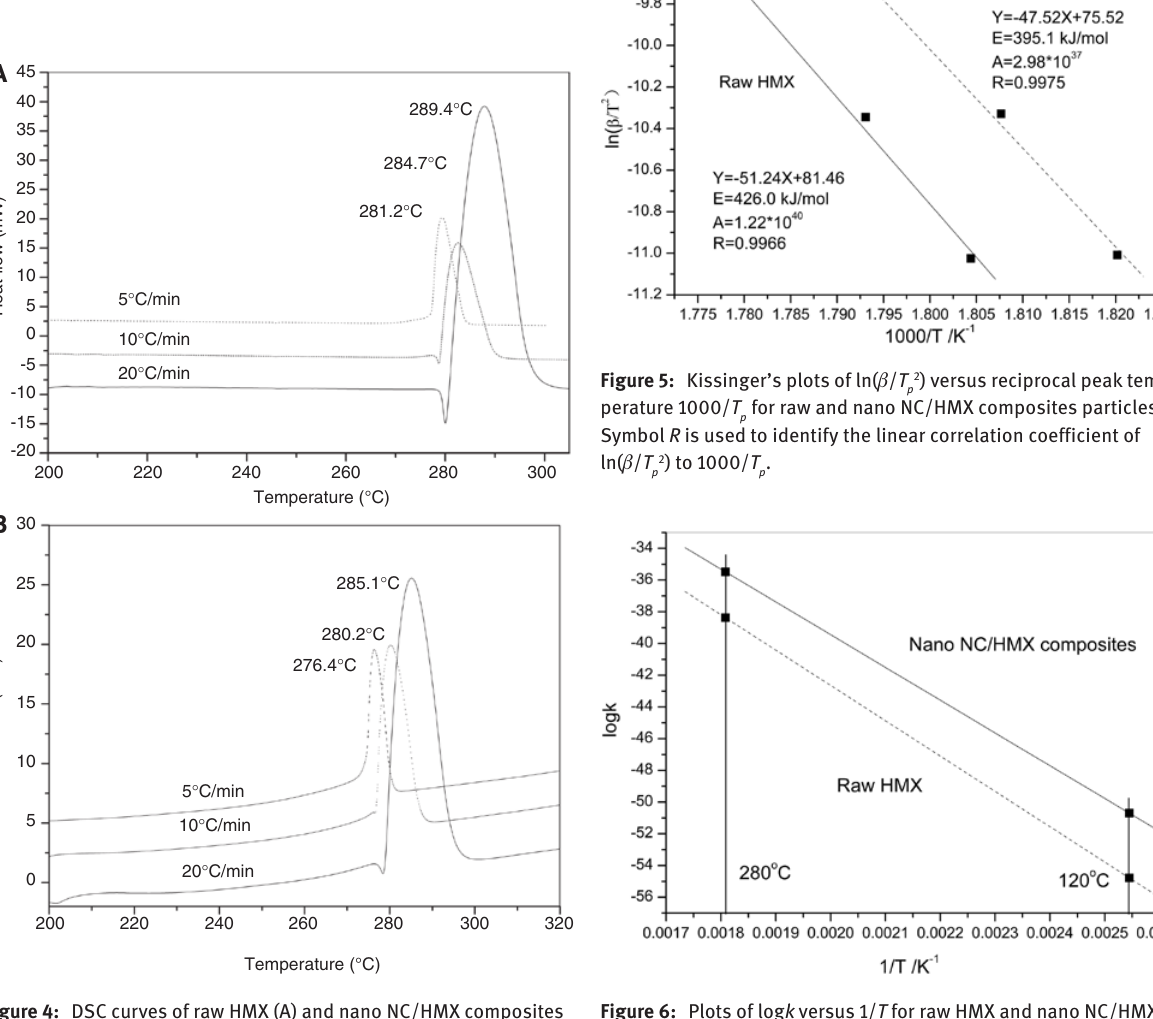
Figure 4: DSC curves of raw HMX (A) and nano NC/HMX composites (B) at heating rates of 5 ° C/min, 10 ° C/min, and 20 ° C/min.